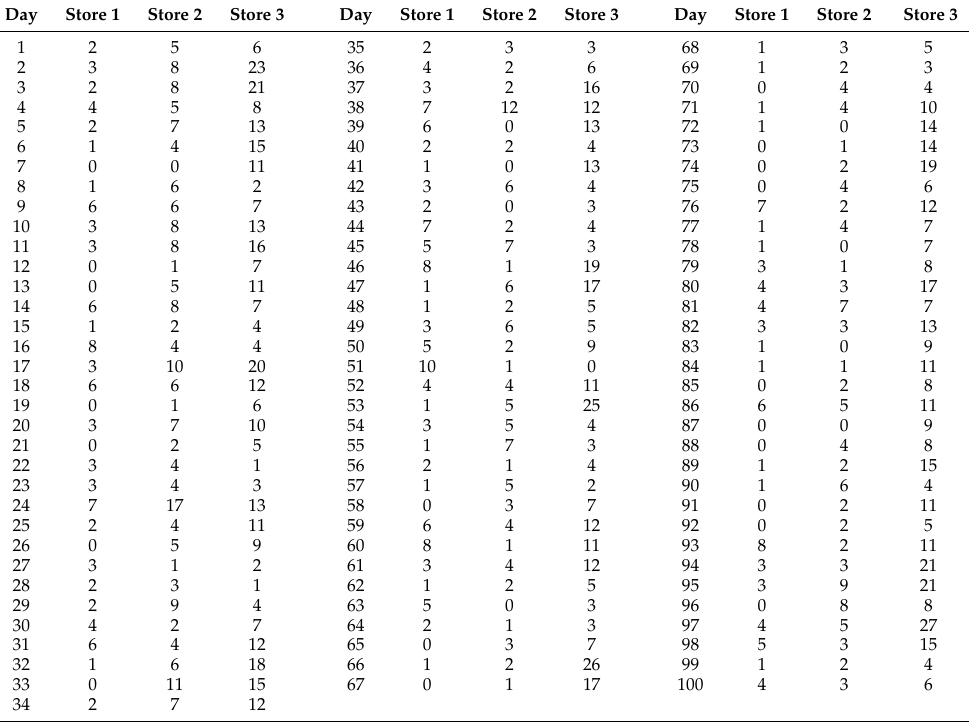
Table A2. Corporación Favorita sales data: Unit sales of an item in each of three stores over 100